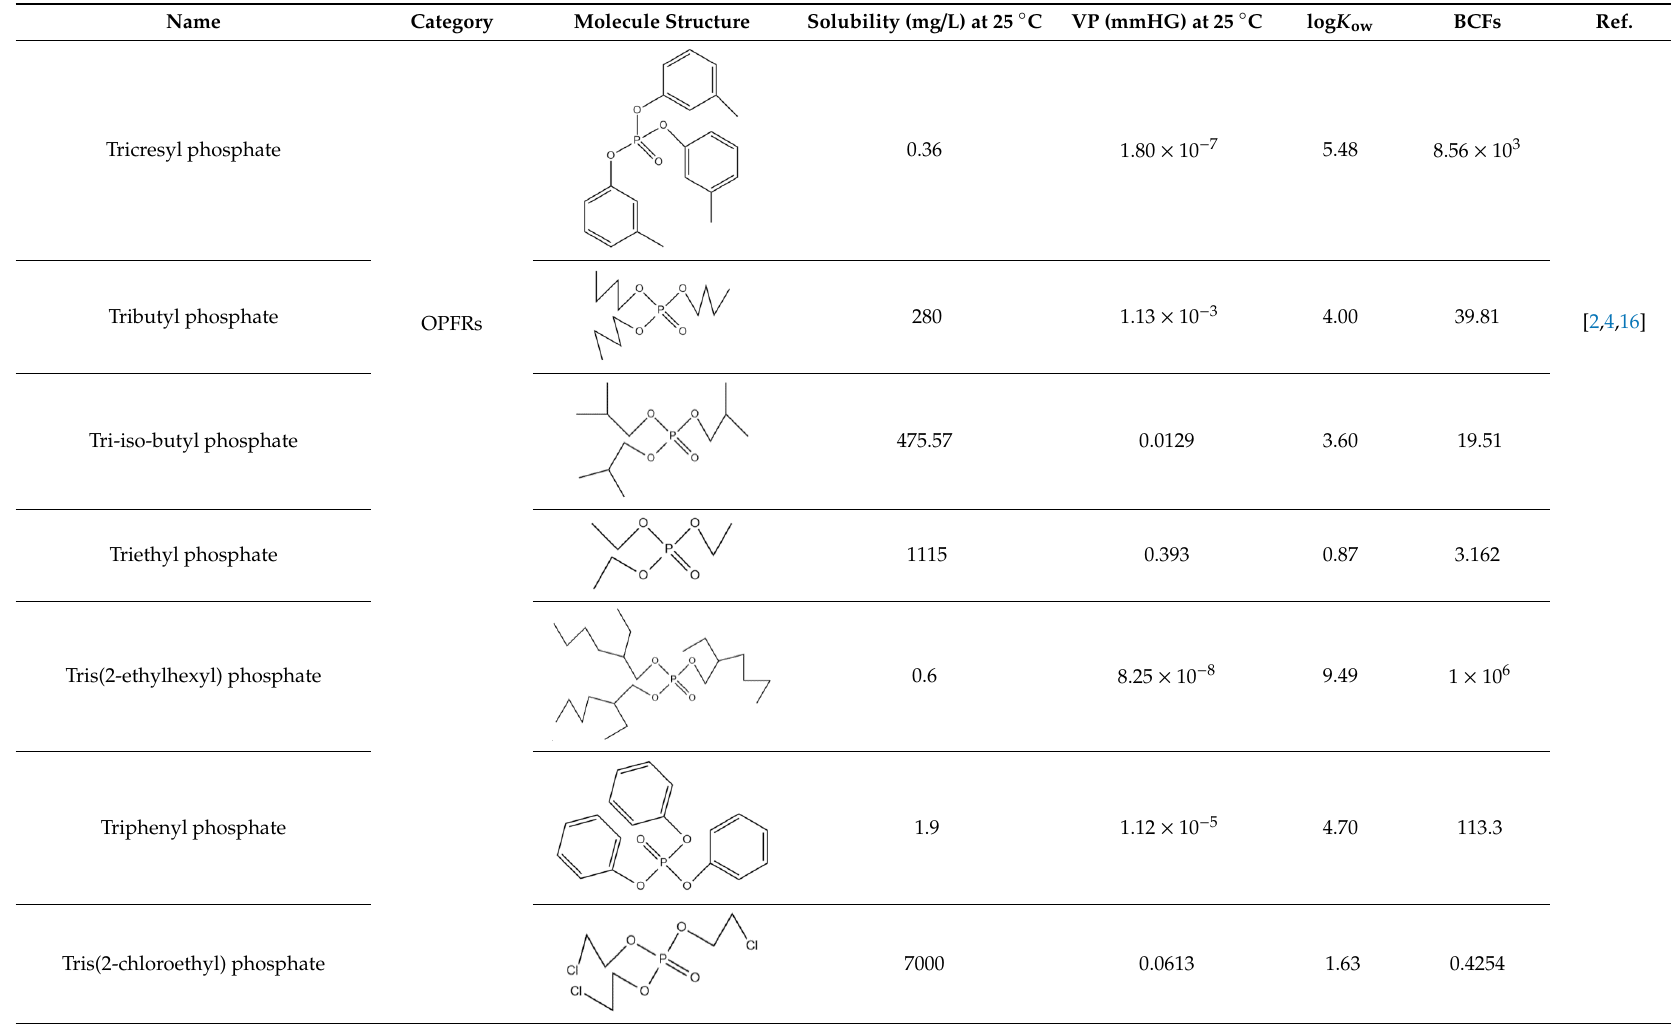
Table 2. Comparison of organophosphate flame retardants (OPFRs) with other flame retardants (FRs).